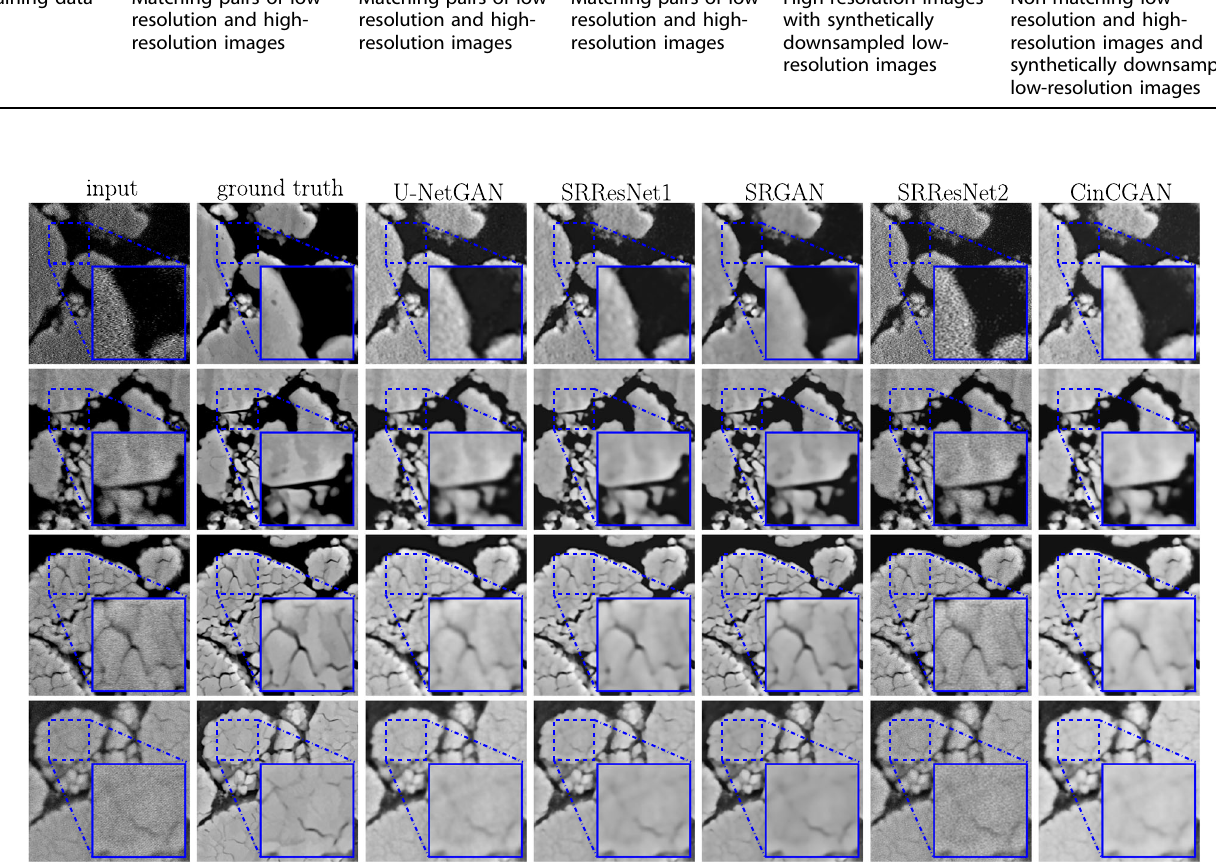
Fig. 3 Visual comparison of super-resolution results. For four different cutouts (rows 1 – 4), super-resolution results are shown which have been obtained by fi ve trained networks. Experimentally measured (noisy) low-resolution images which serve as input are depicted in the fi rst column. The corresponding (denoised) high-resolution images are shown in the second column. They serve as ground truth. The super- resolution results obtained by U-NetGAN, SRResNet1, SRGAN, SRResNet2, and CinCGAN are depicted in columns 3 – 7, respectively. Magni fi cations with a zoom factor 2 of the dashed blue squares are visualized in the blue solid-lined squares.